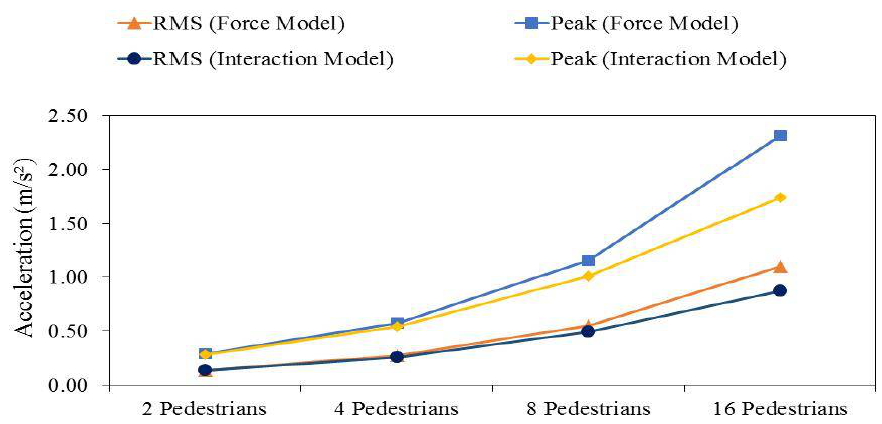
Figure 13. Results from changes in the modal mass.